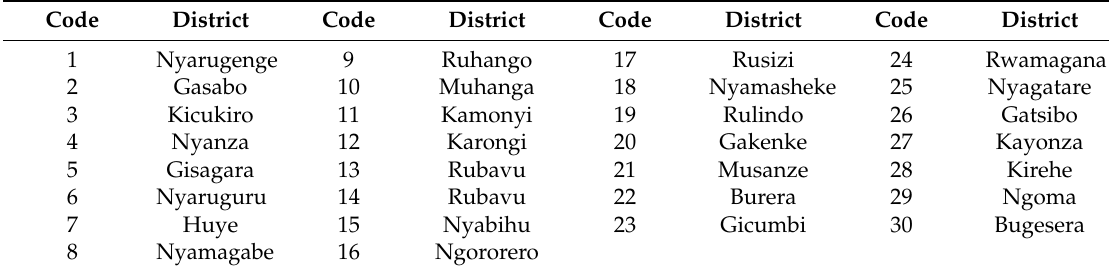
Figure 3. Structured spatial effects on contraceptive use among women of childbearing age. Table 6. Districts of Rwanda and their codes used in RDHS 2014/15.